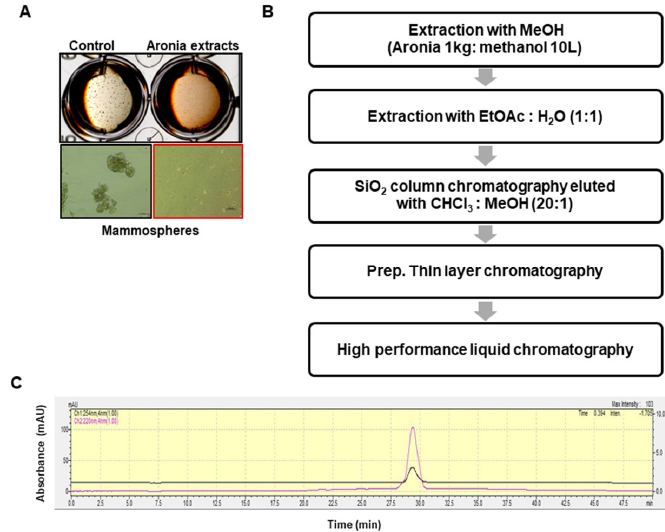
Figure 1. Isolation of the cancer stem cell (CSC) inhibitor from aronia and assessment of the aronia extracts via mammosphere formation assay. ( A ) Assay of mammosphere formation inhibition using aronia extracts. The mammospheres were incubated with aronia extracts or DMSO. MDA-MB-231 cells were treated with aronia extracts or DMSO in CSC culture media for seven days. Images were obtained by microscopy at 10 × magnification and were representative mammospheres (scale bar = 100 µ m). ( B ) Isolation procedure of the mammosphere-forming inhibitor. ( C ) HPLC chromatogram of the inhibitor isolated from the aronia extracts. Int. J. Mol. Sci. 2018 , 19 , x FOR PEER REVIEW